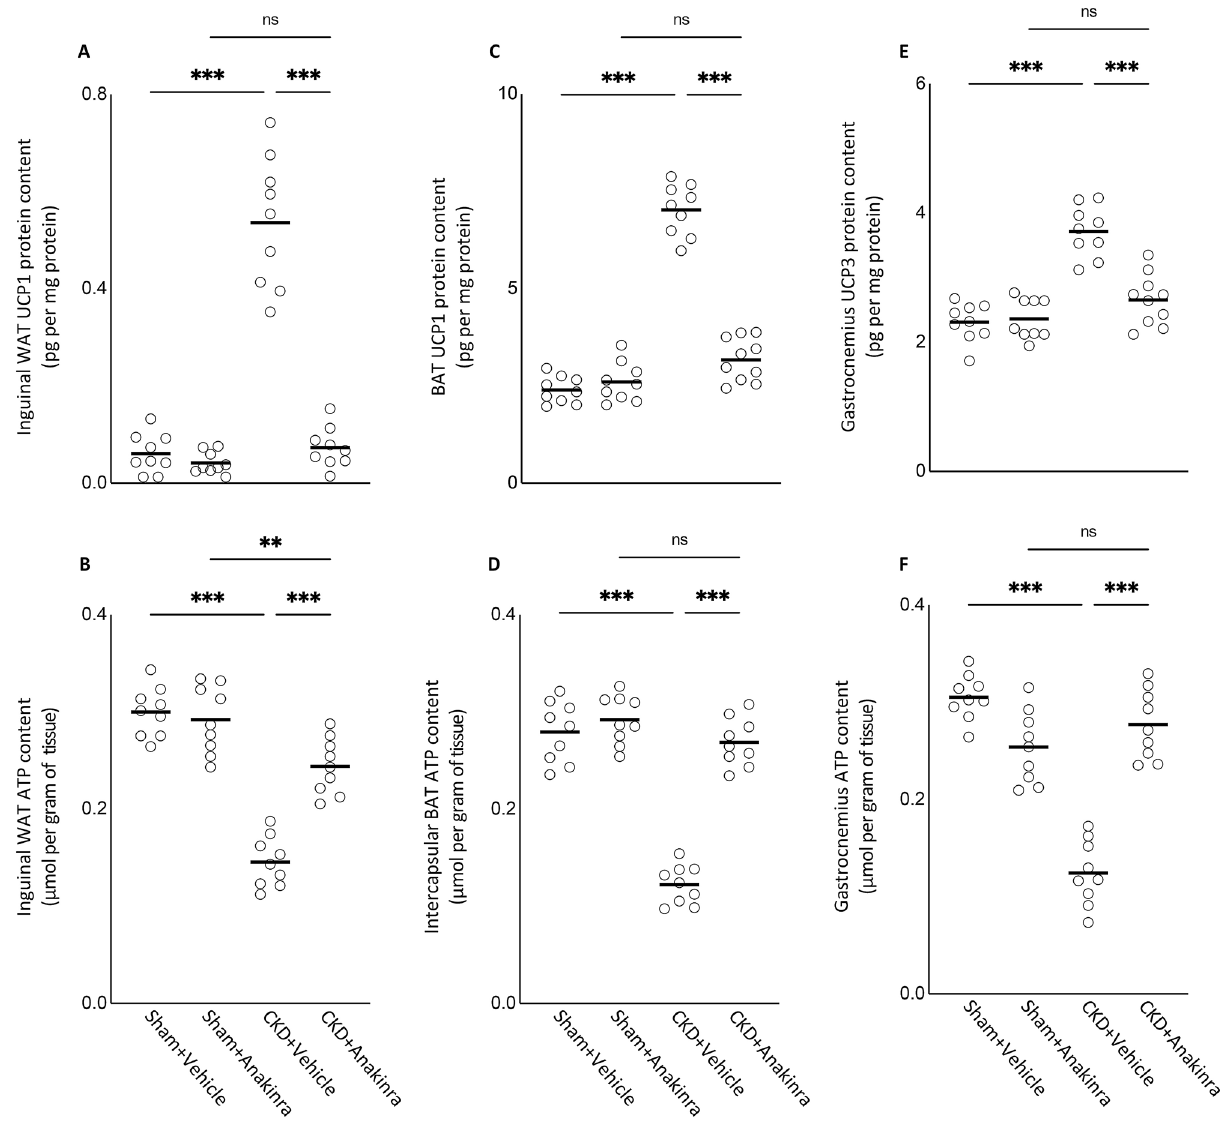
Figure 4. Anakinra ameliorates energy homeostasis in skeletal and adipose tissue in CKD mice. UCP content ( A , C , E ) and ATP protein content ( B , D , F ) in adipose tissue (inguinal white adipose tissue and brown adipose tissue) and gastrocnemius muscle were measured. Final results were expressed in arbitrary units, with one unit being the mean level in WT/Sham + Vehicle mice. Results of WT/CKD + Vehicle were compared to WT/ Sham + Vehicle and WT/CKD + Anakinra were compared to WT/Sham + Anakinra, respectively. In addition, results of WT/CKD + Anakinra were also compared to WT/CKD + Vehicle. * p < 0.05, ** p < 0.01, *** p <